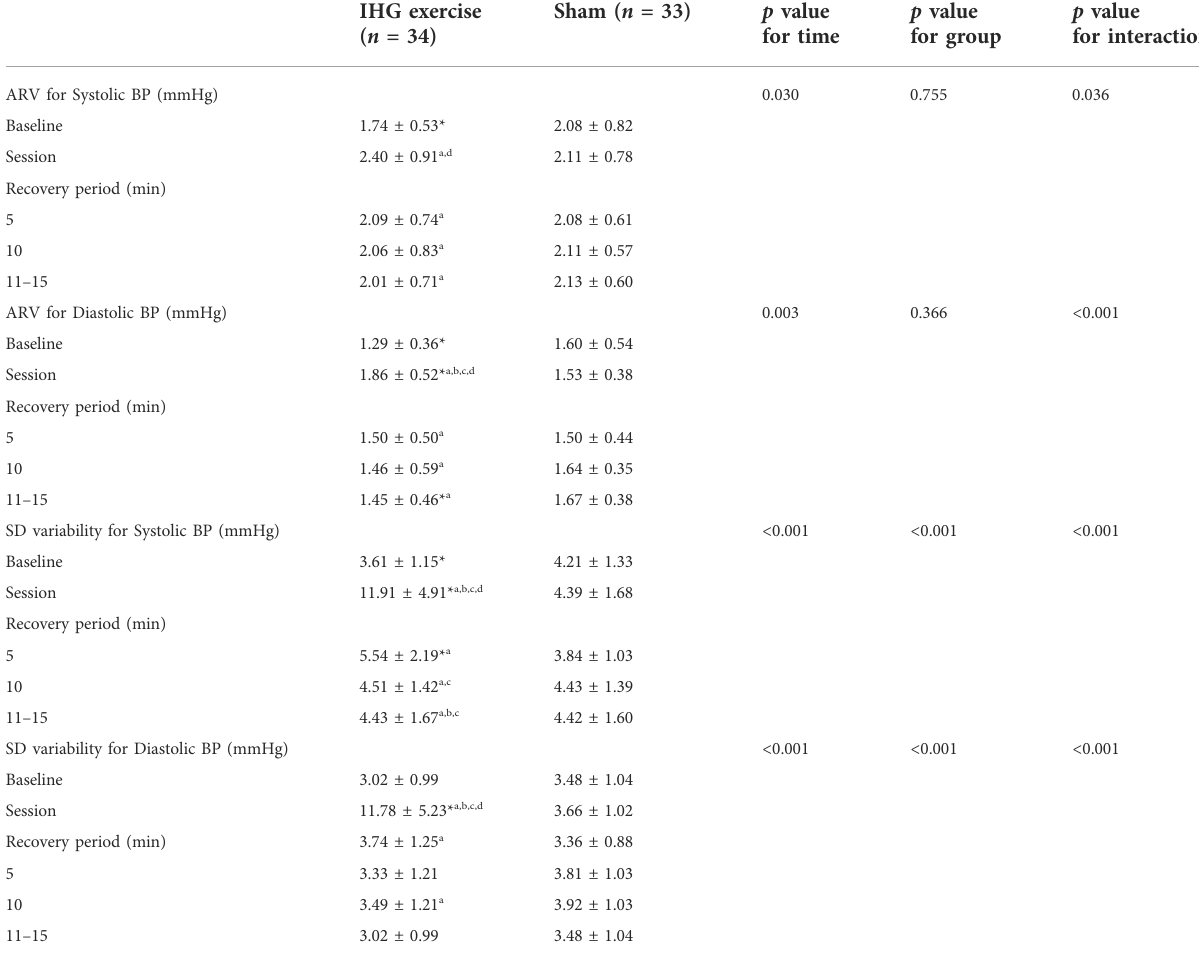
TABLE 2 Very short-term BP variability assessed at the laboratory before, during and after the isometric handgrip exercise (IHG) and sham